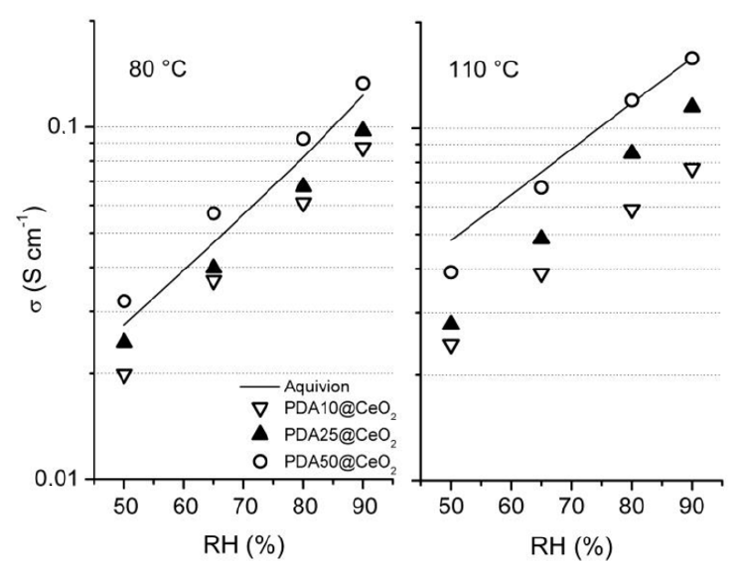
Figure 7. Conductivity as a function of relative humidity, at 80 and 110 °C, for composite Aquivion membranes containing 5 wt% PDAx@CeO 2 . The conductivity of bare Aquivion is also reported.